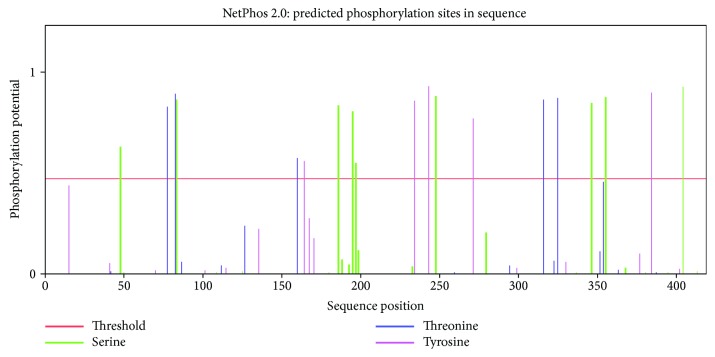
Prediction of phosphorylation sites in GpSS. These include 48S, 84S, 187S, 196S∗, 198S, 249S, 349S, 358S, and 407S∗; 78T, 83T, 161T, 318T, and 327T; and 165Y, 236Y, 246Y, 273Y, and 387Y.